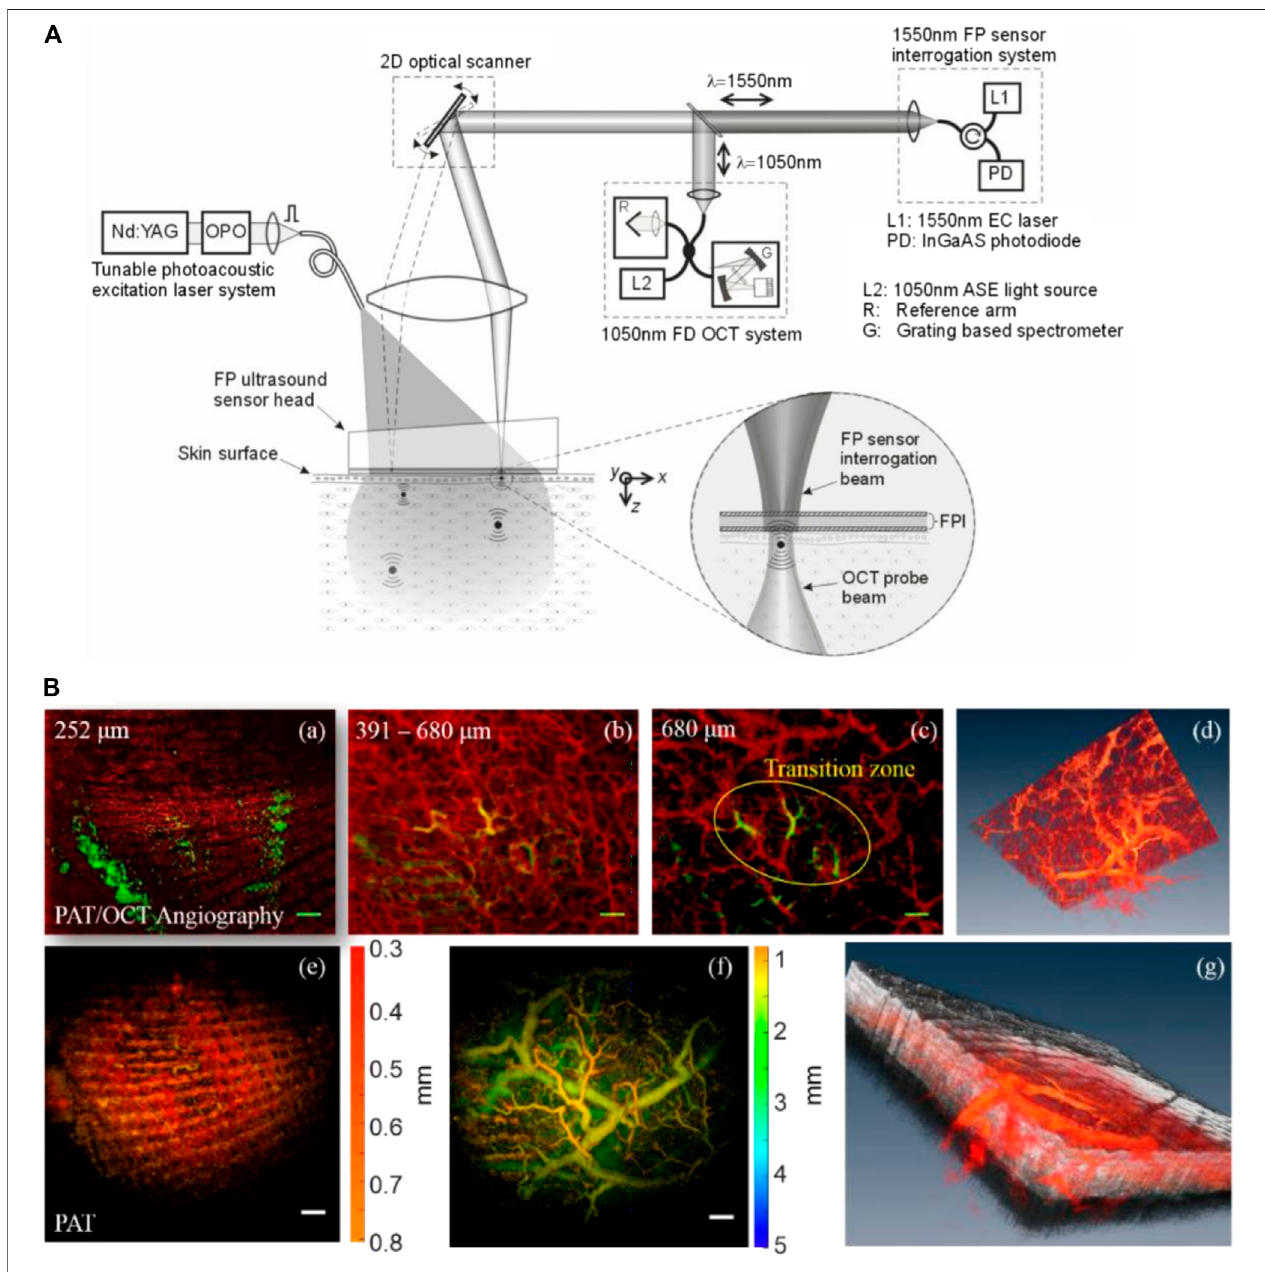
FIGURE 9 | (A) Dual-modal PAT-OCT scanner. Reprinted with permission from [151]. (B) (a – c) overlaid PAT-OCTA images with PAT in the green channel and OCTA in the red channel. (d) Blood vessel network given in volumetric display by fused OCTA and PAT data. (e) PAT image. (f) PAT image in deeper region. (g) A snapshot of the 3D volume with OCT in gray, OCTA, and PAT in red color map. Scale bar (cid:2) 1 mm. Reprinted with permission from [153].